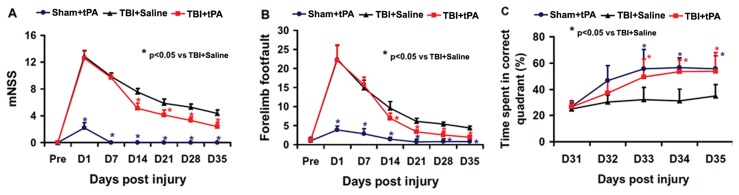
tPA effect on functional outcome.tPA significantly lowered the mNSS scores (A) and reduced frequency of foot faults (B) from Day 14 to 35 after TBI compared to the saline group. tPA treatment significantly improved spatial learning performance from Day 33 to 35 after TBI compared with the saline group (C). *p<0.05 vs TBI+Saline. Data represent mean ± SD. n = 8 (rats/group).